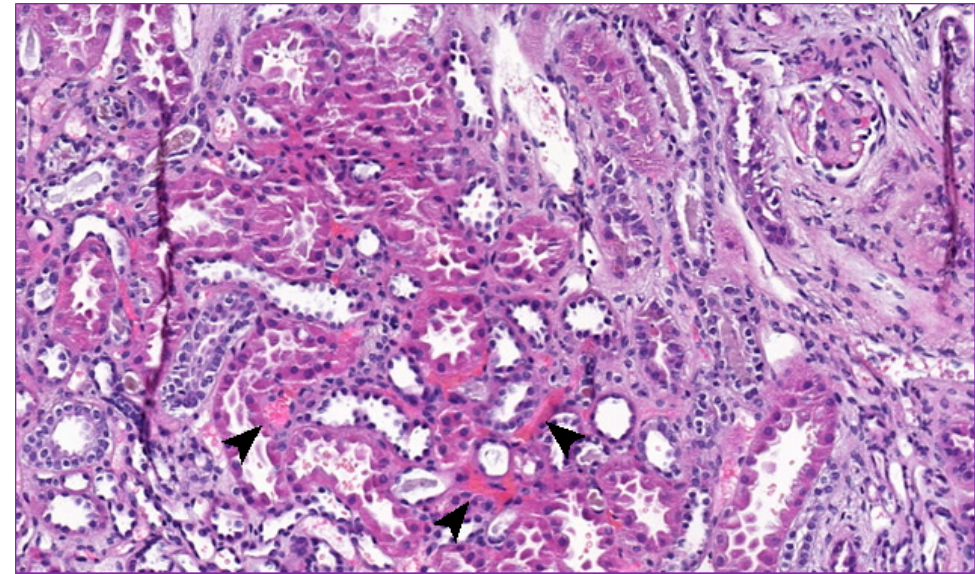
Figure 2. Small fibrin thrombi are visible in the interstitium (arrowheads).